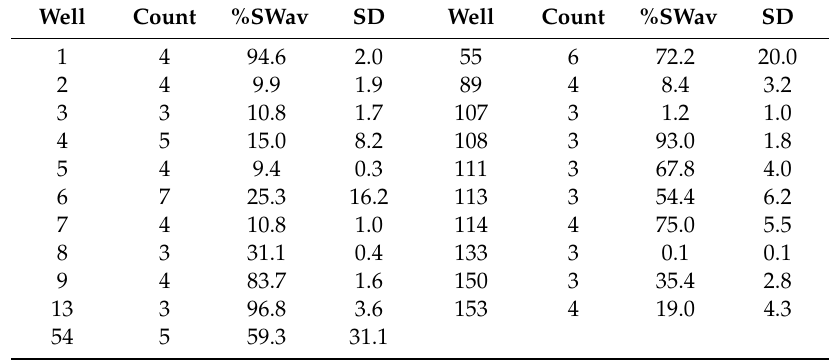
Table 2. Average percentage of seawater (%SWav) and standard deviation (SD) in sampled waters. Well